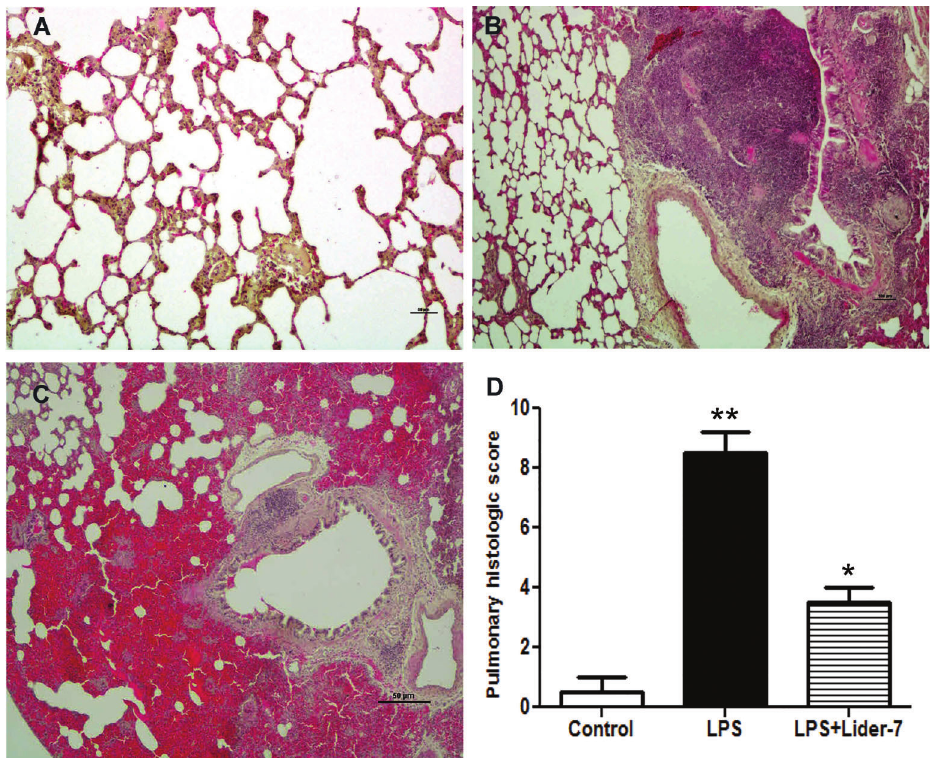
Figure 1. Histopathological changes in lung tissue samples of the three groups. Hematoxylin and eosin ( (cid:1) 200 magni fi cation). A , Control group with normal lung structure. B , Lipopolysaccharide (LPS) group with increased alveolar wall thickness, edema, bleed- ing and in fi ltration of in fl ammatory cells. C , LPS + Lider-7 group showed less structure destruction and in fl ammatory in fi ltration. D , Comparison of the pulmonary histological scores of the three groups. Data are reported as means ± SD. *P o 0.05, LPS + Lider-7 group compared to control group; **P o 0.001, LPS group compared to control group (one-way